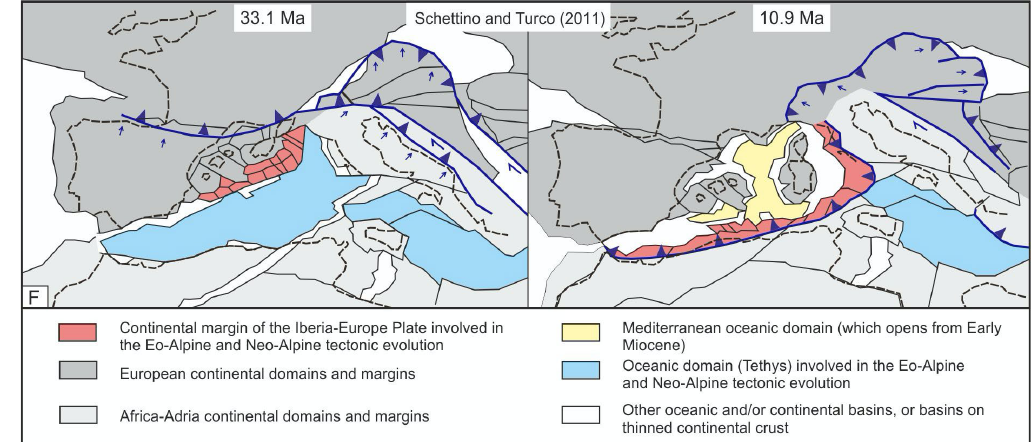
Figure 4 Figure 4. Reproduction of evolutionary paleogeographic sketch maps showing the evolution of the central-western Mediterranean region from 33.1 my (late Cretaceous) to 10.9 my (late Miocene) and considering the presence of a single ocean between African and European Plates (elaboration according to Plate kinematics-based models; after [44],